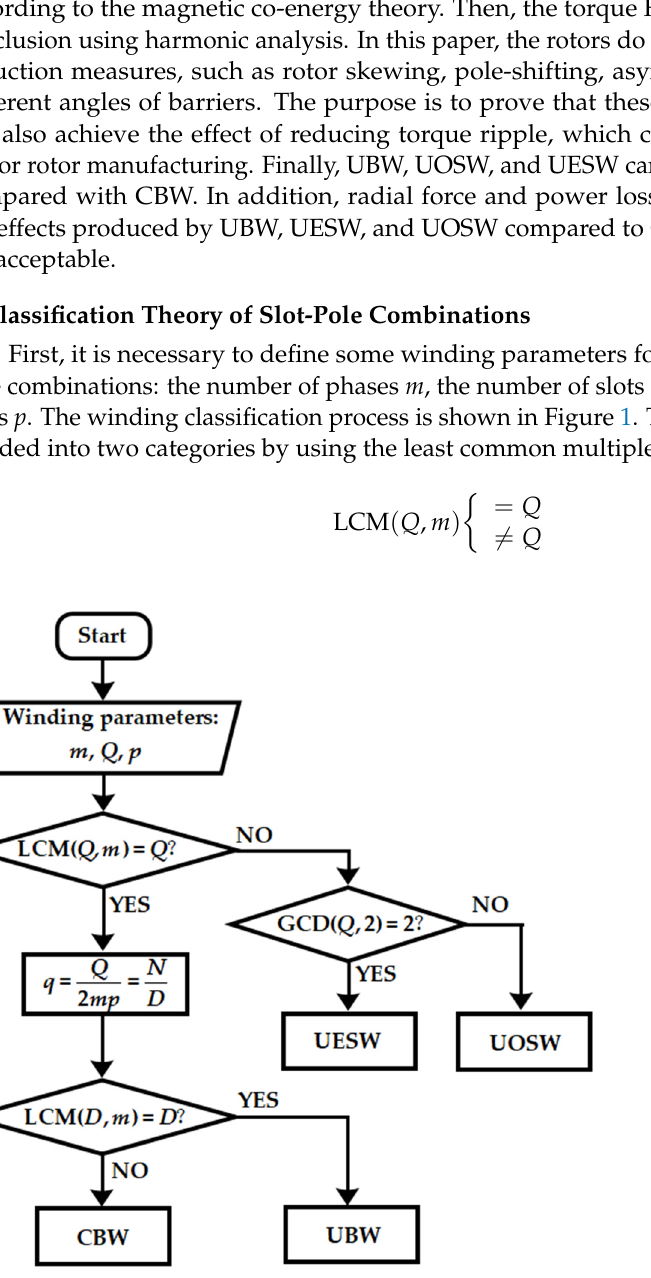
Figure 1. Classification of slot-pole combinations.